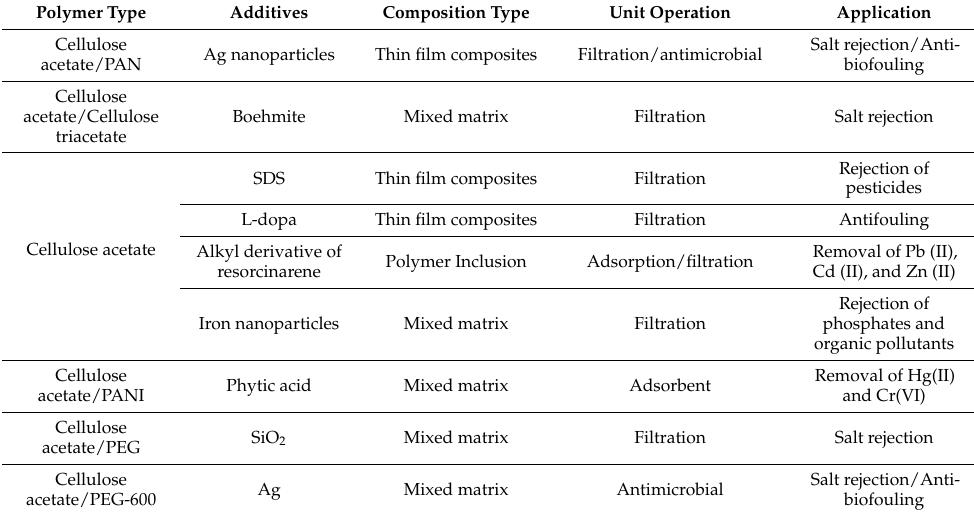
Table 1. Summary of cellulose acetate composite